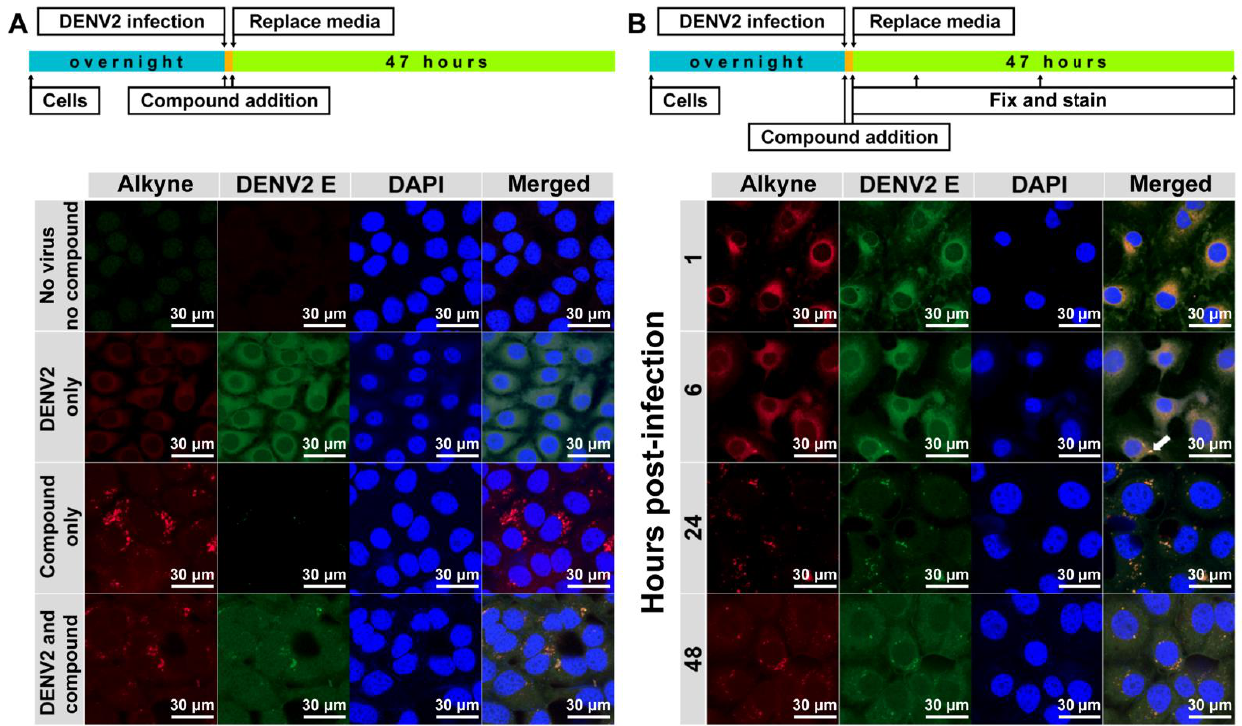
Figure 3. Subcellular localization ( A , B ) of alkyne-tagged apigenin. DENV2 NGC (MOI of 1) and the newly synthesized alkyne-tagged apigenin (10 µM) were added to LLC/MK2 (10 5 ) cells in a 12 mm presterilized coverslip and incubated for 48 h, unless indicated otherwise, at 37 ◦ C under 5% CO 2 . Cells were fixed and permeabilized by acetone before washing with 1% bovine serum albumin (BSA) in phosphate buffer saline (PBS) and staining with Click-iT ® reaction cocktail